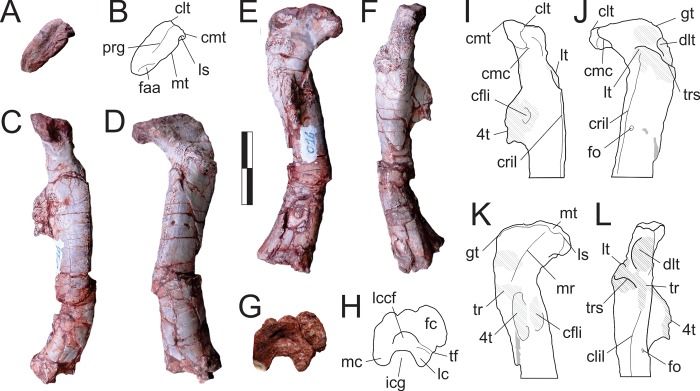
Pampadromaeus barberenai (ULBRA-PVT016), femur.Photographs (A,C-G) and drawings (B,H-L) of the left femur in (A-B) proximal, (C,I) craniomedial, (D,J) craniolateral, (E,K) caudomedial, (F,L) caudolateral, and (G-H) distal views. Abbreviations: as in Fig 23, plus fc, fibular condyle; fo, foramen; icg, intercondylar groove; lc, lateral condyle; lccf, facet for Lig. cruciatum craniale; mc, medial condyle; tf, trochlea fibularis; tr, transverse ridge. Grey areas indicate parts broken or covered by sediment; hatched areas indicate muscle insertions. Scale bar = 3 cm.